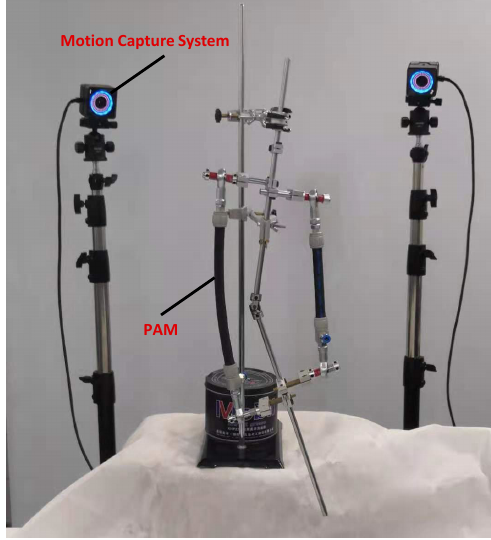
Figure 16. Experimental system